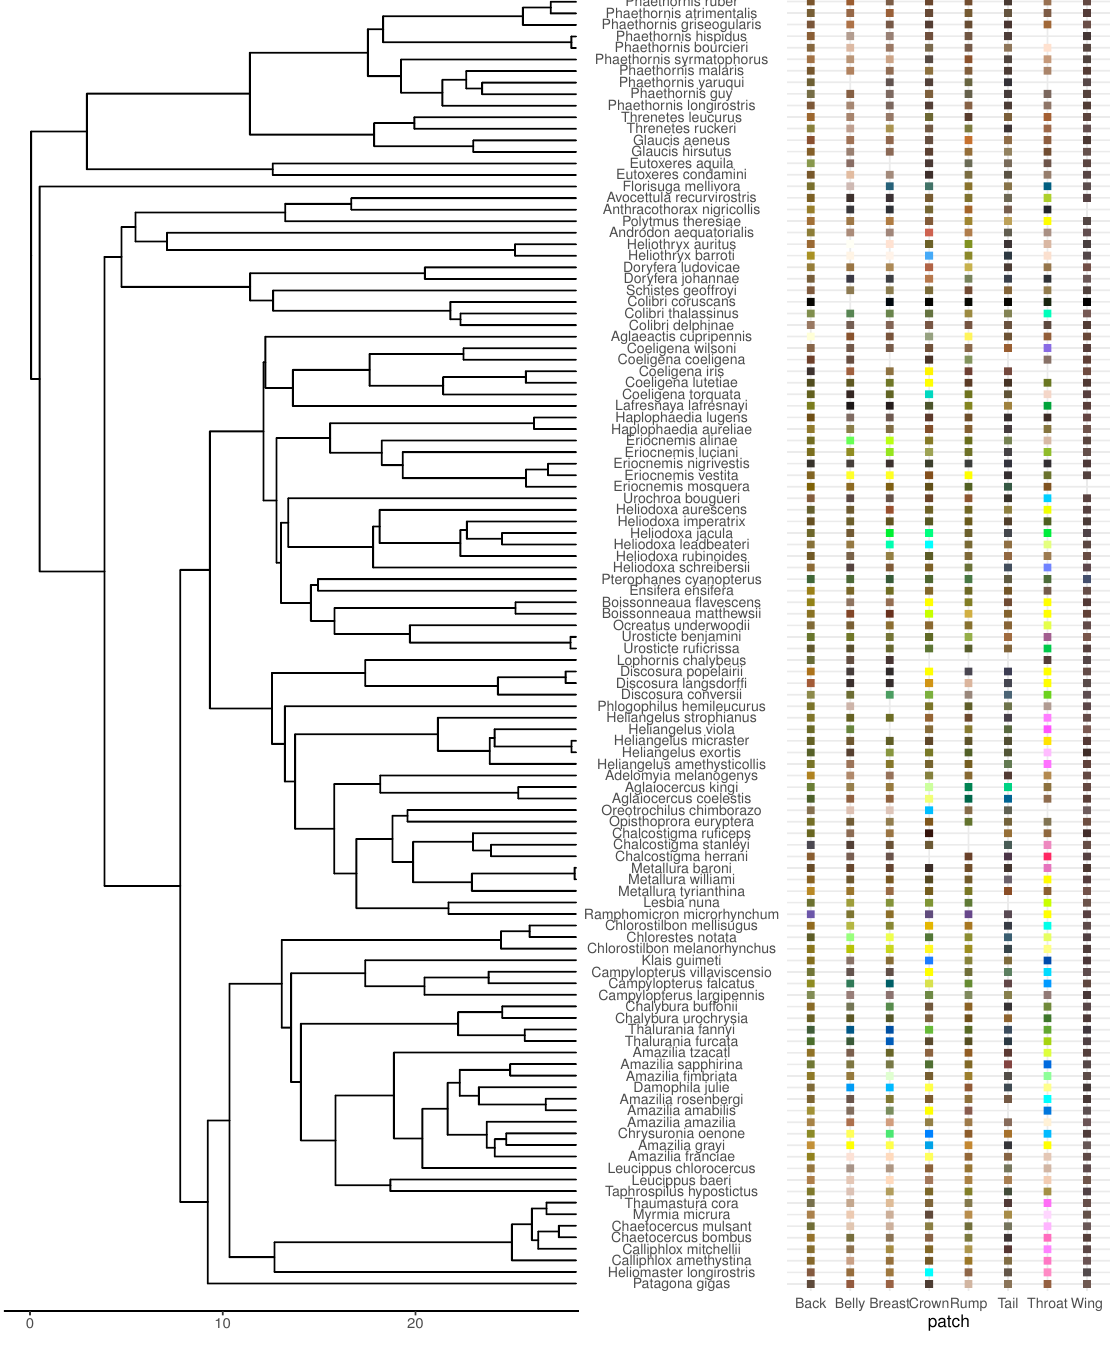
Supplementary figure 4 – Colour of the 8 main patches for each species in our dataset. The colour corresponds to the colour in the human visual system (CIE10). The x-axis on the phylogeny is in millions